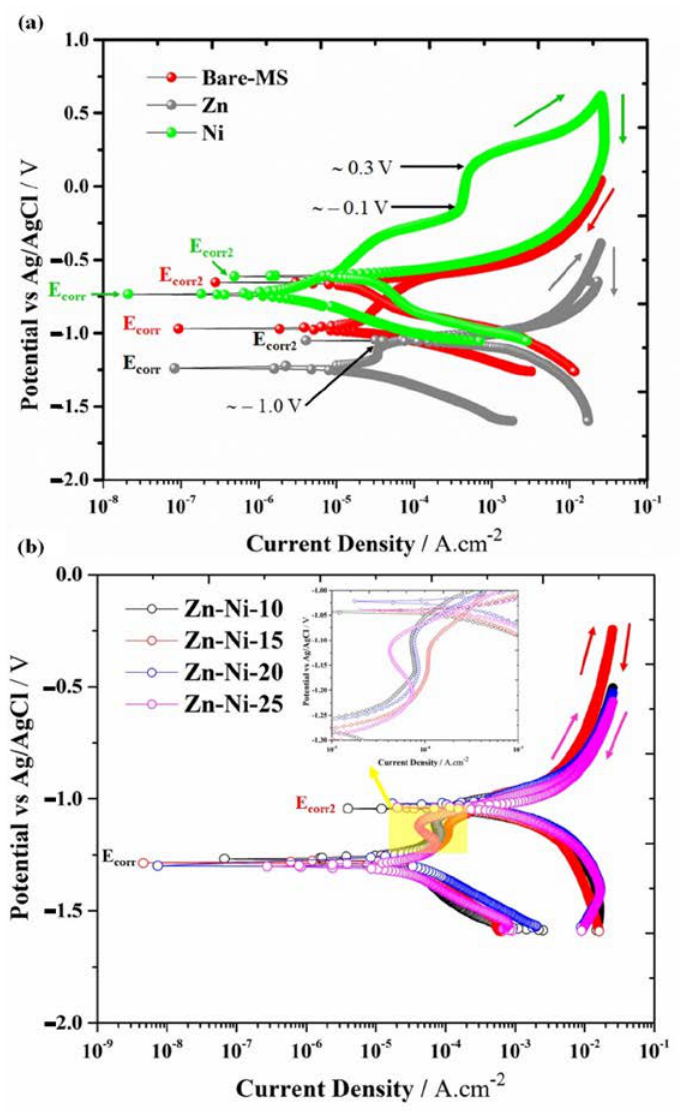
Figure 7. Cyclic polarization scan comparison between ( a ) bare steel substrate, pure zinc and pure nickel coating ( b ) Zn-Ni alloy coating .